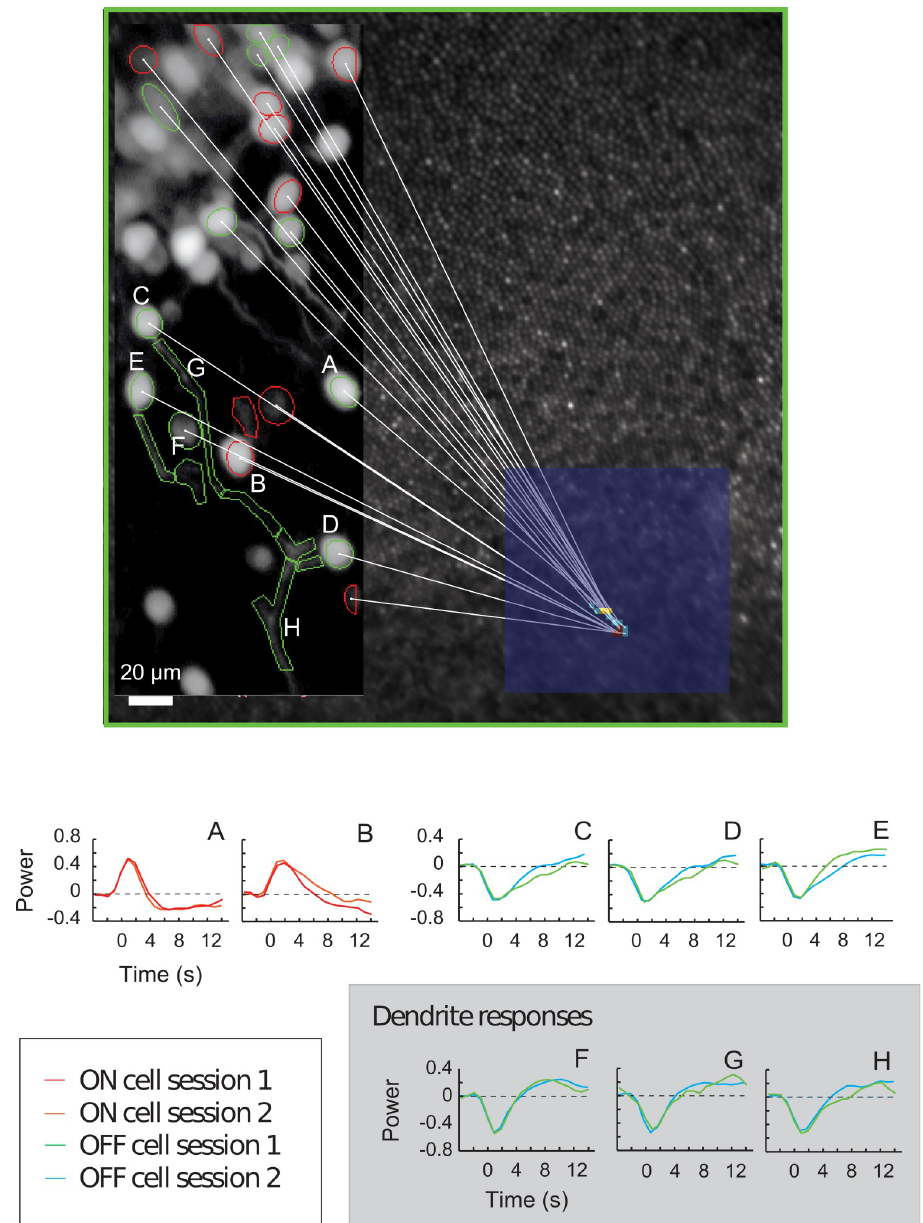
Fig 8. Consistency of receptive field mapping across sessions. A . Map of the locations of cells and dendrites whose consistency of response is shown in Fig 8B. B . Temporal impulse response of retinal ON dominant RGCs (A and B) OFF dominant RGCs (C, D and E) and dendrites (F,G and H) on two imaging sessions separated by one